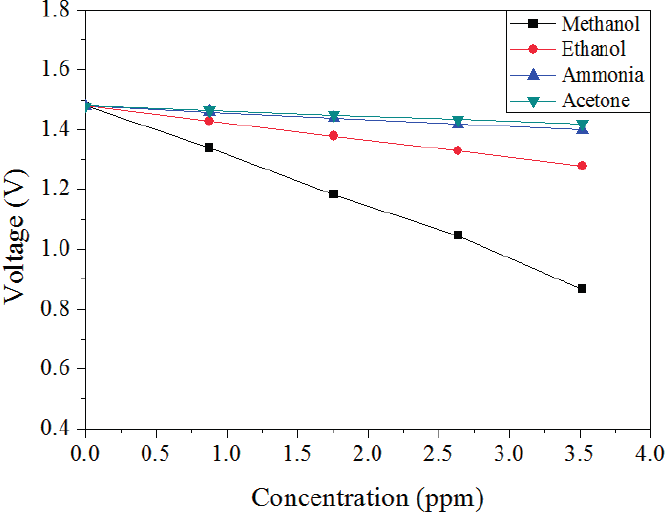
Figure 14. Output voltage of the sensor under different